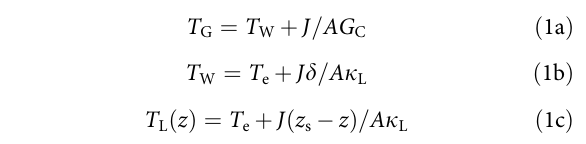
( B 0.12 W m (cid:2) 1 K (cid:2) 1 ), and the convectional contribution can be neglected. z s is the position of surface in the lipid bilayer. d and k L are the thickness and thermal conductivity of the lipid bilayer, respectively. T e ¼ 300 K is the temperature of the water reservoir in contact with lipid bilayer on the other side, or the heat sink.